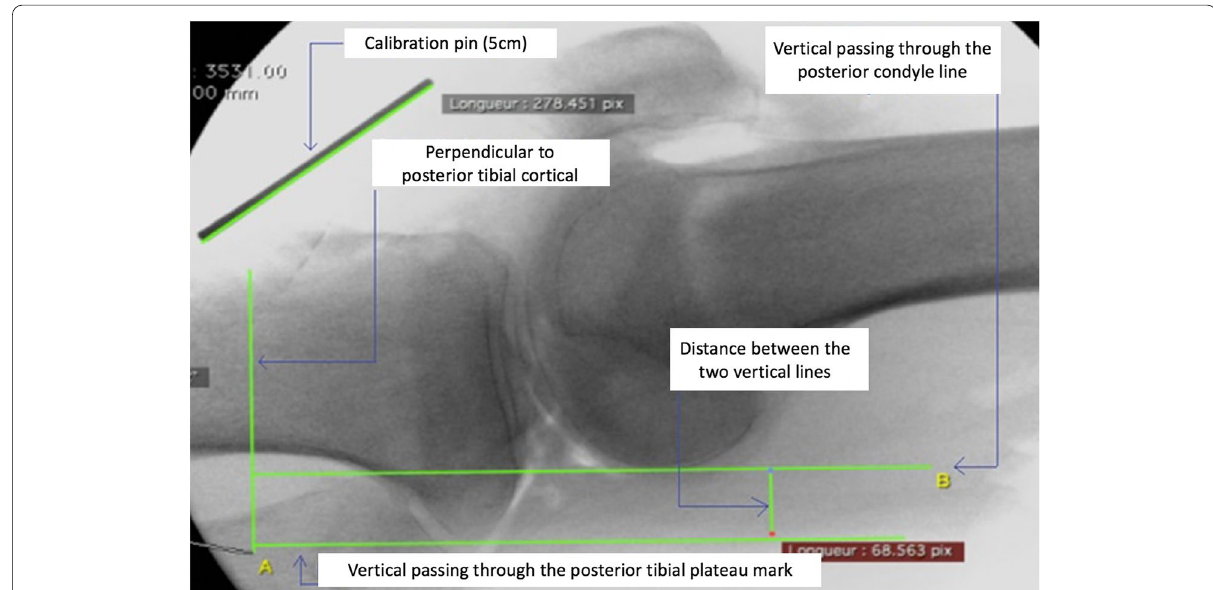
Fig. 3 Analysis of a lateral radiographic image of the knee in extension with posterior stress with the conventional translation technique